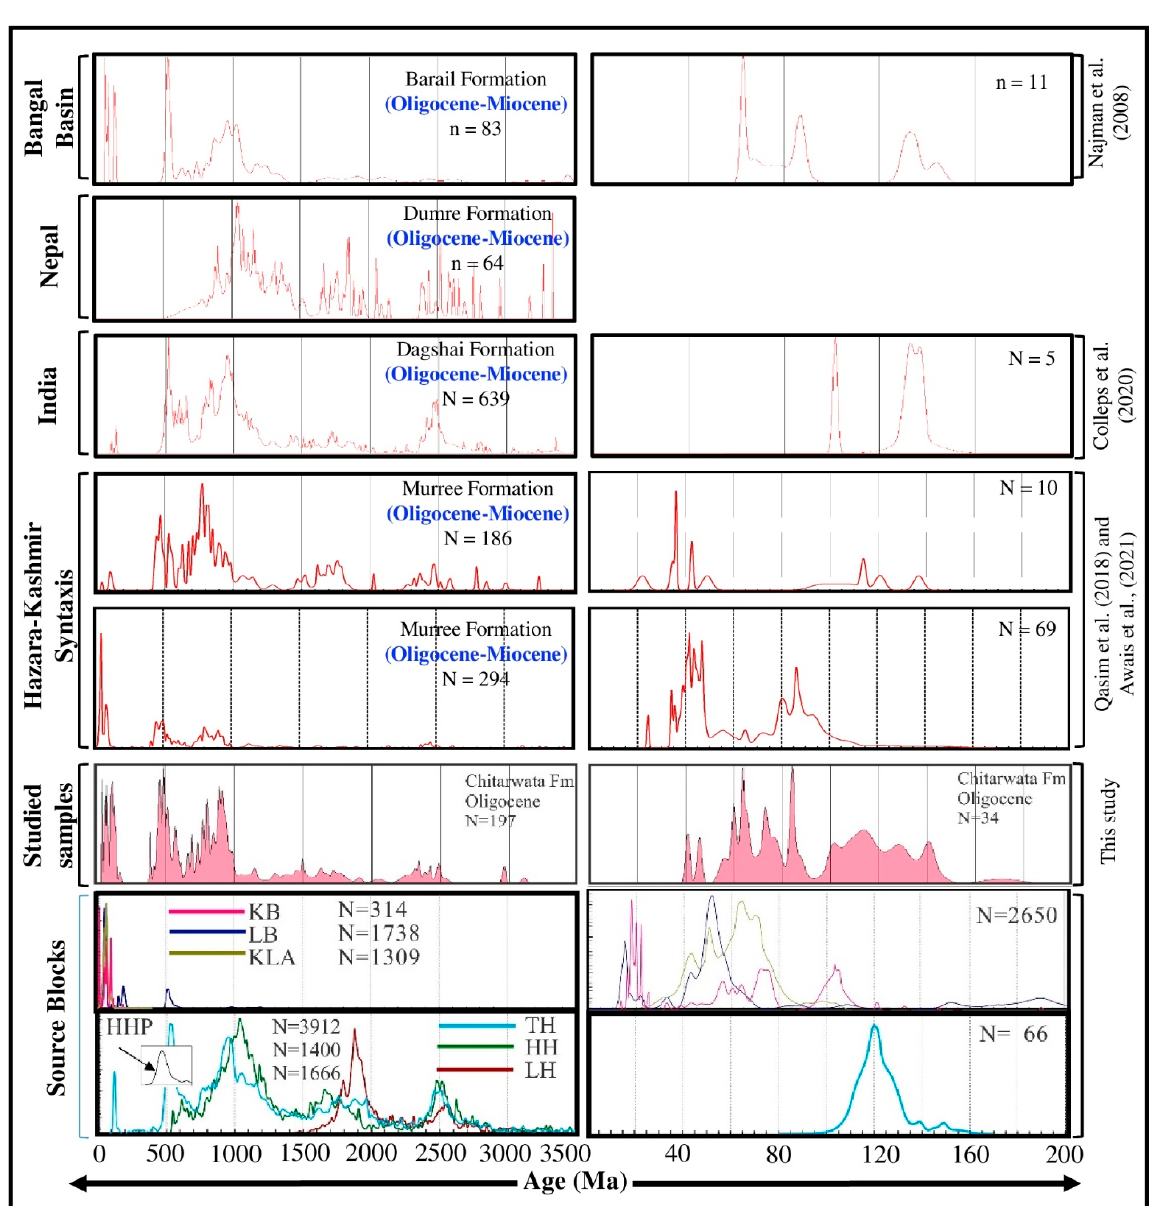
Figure 6. Comparison of the composite PDPs of the studied detrital zircon samples with the adjacent source regions [3,47,52,53], and coeval sedimentary units exposed along the strike [8,54,55]. Where